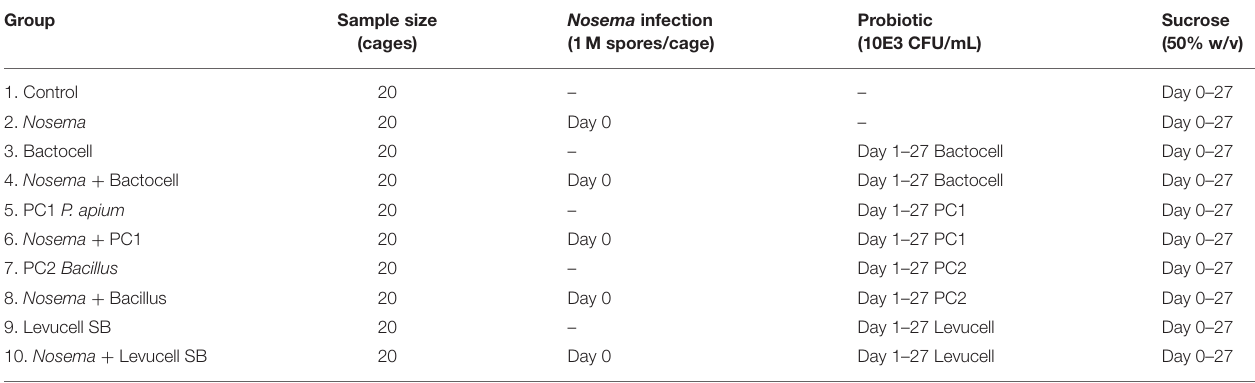
TABLE 1 | Experimental groups (20 bees in each cage for a total of 400 bees in each experimental group).